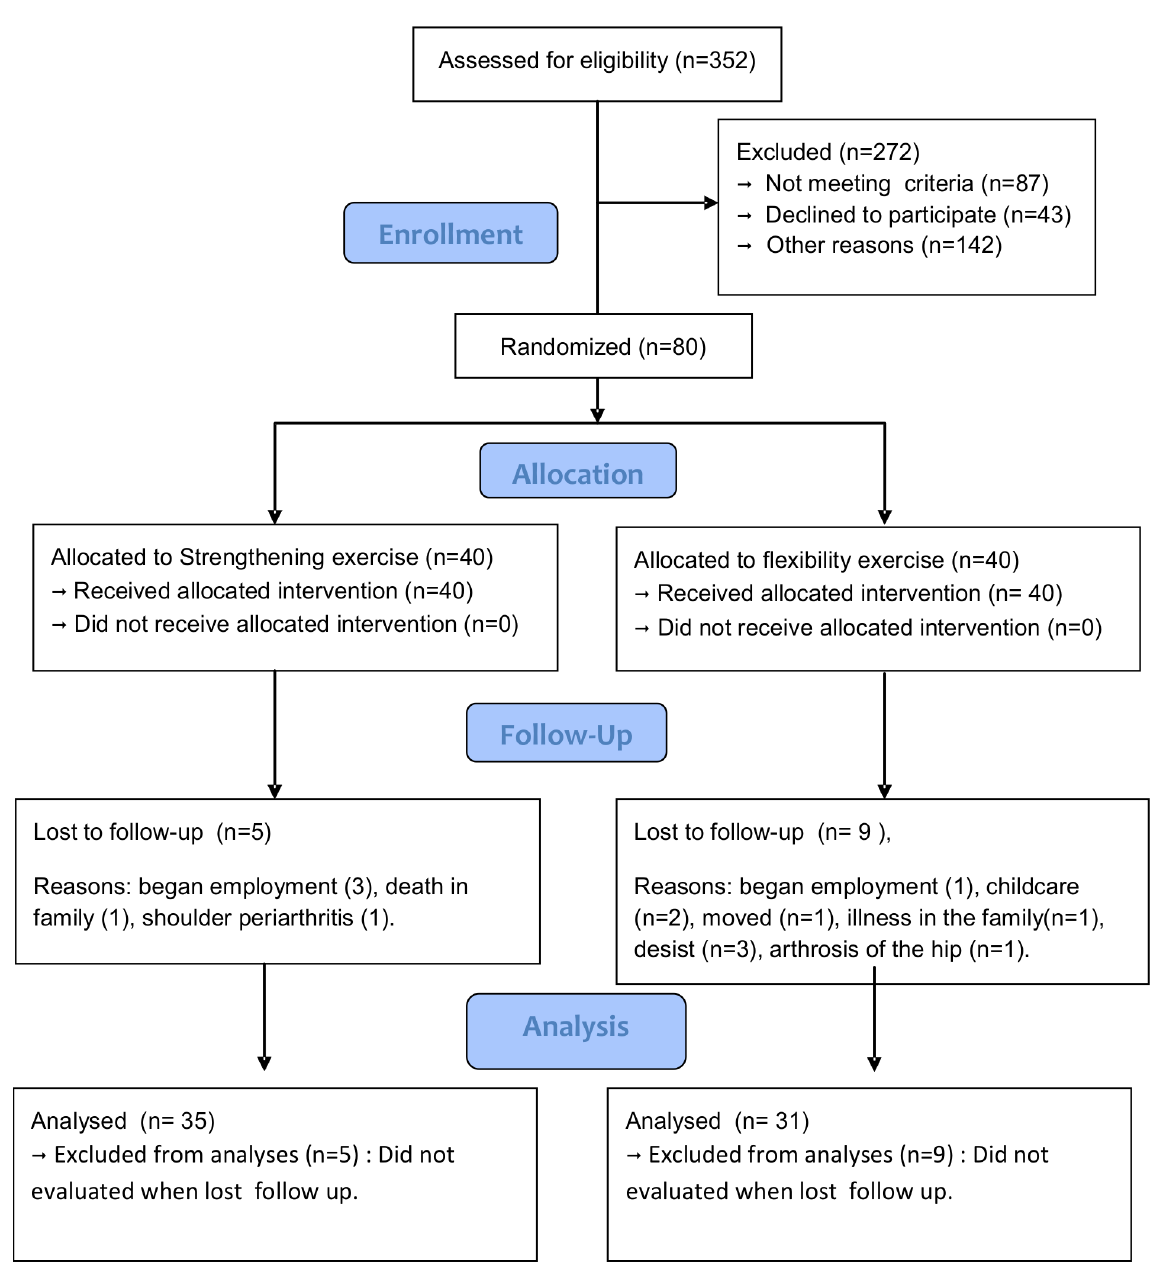
Figure 1. Study design and flow chart.